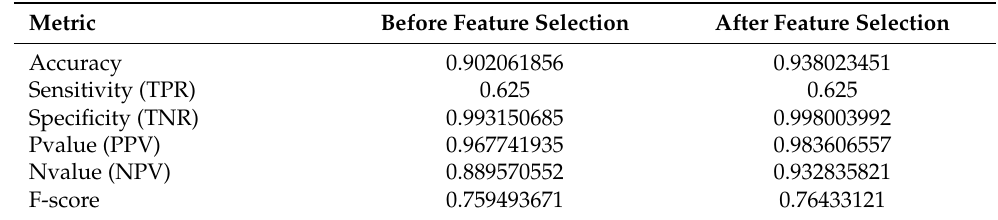
Table 9. Comparison between the classification results with and without the proposed feature selection algorithm,